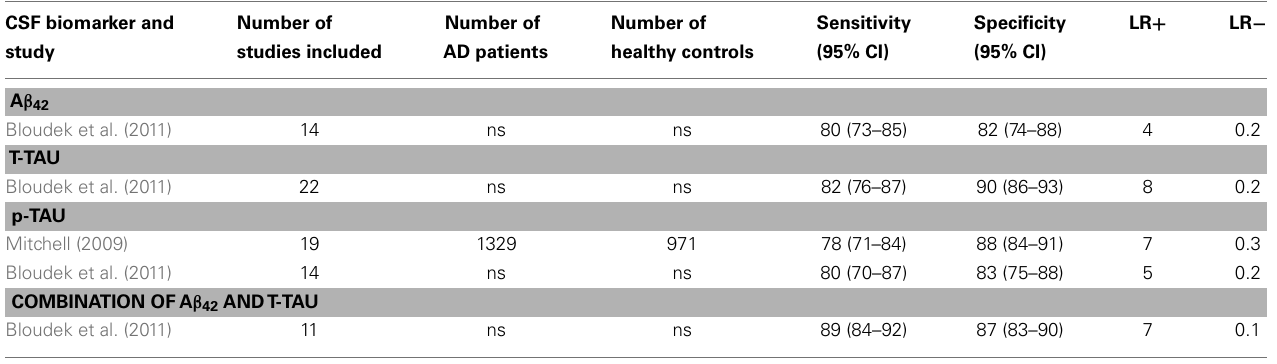
Table 2 | Systematic reviews with meta-analyses (AD vs. healthy controls): sensitivity and specificity values.